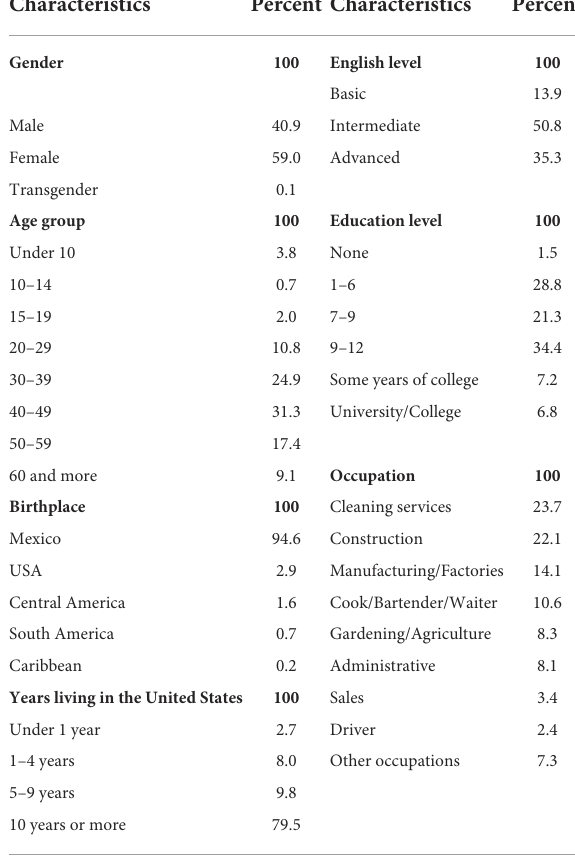
TABLE 2 Main socio-demographic characteristics of the population served at VDS and MHU, January 2020-July 2021 * N =